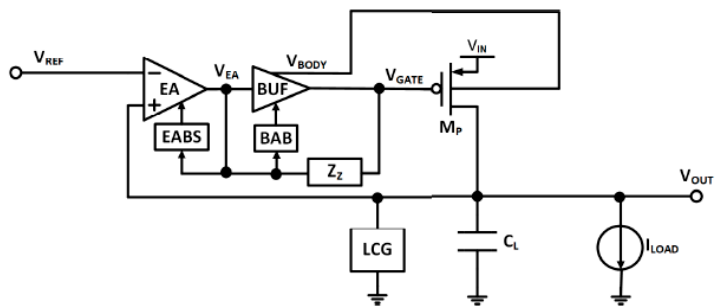
Figure 17. Concurrent Bulk Modulation and FBB-Based ALDO [45].